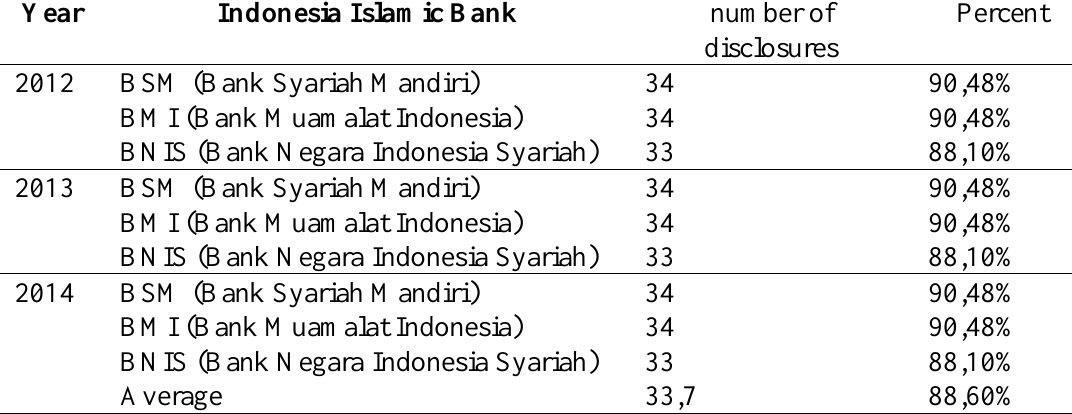
Table 5 Application of GCG of Indonesian Islamic Banks and Malaysia